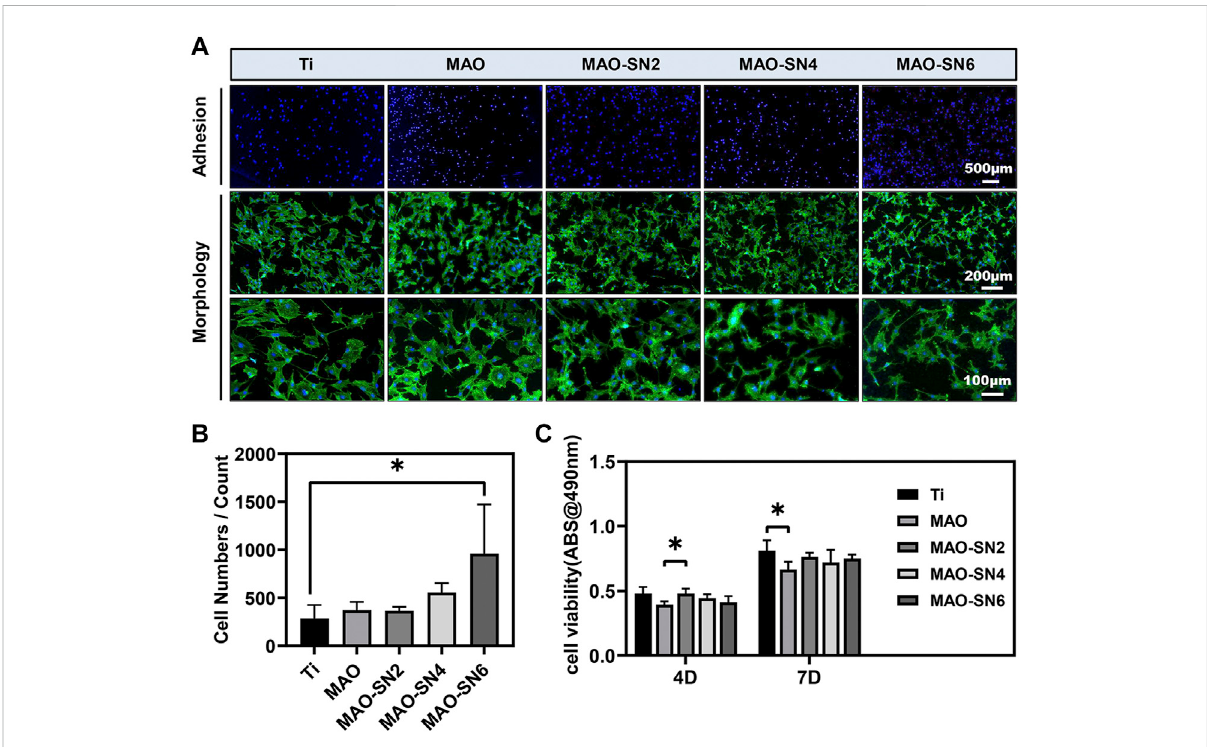
FIGURE 5 (A) Representative staining images of the early adhesion and morphology of MC3T3-E1 cells (green/blue: cytoskeleton/nucleus). Quantitative statistics of cell adhesion numbers (B) and cell viability (C). * p <